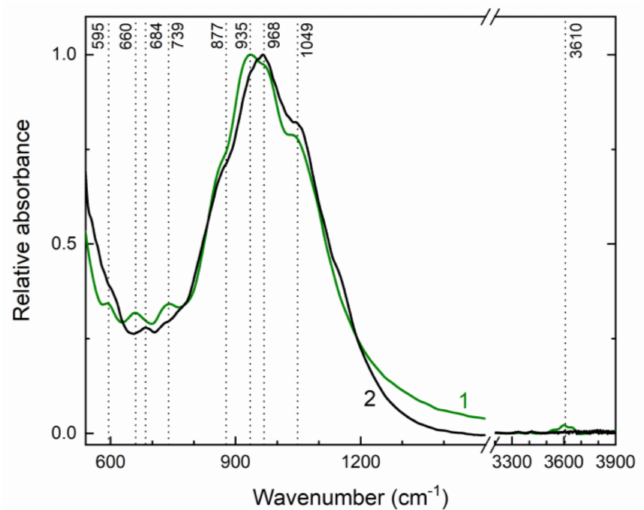
Figure 7. Infrared absorption spectra of initial (green curve 1) and annealed at 750 ◦ C (black curve 2) potassic-hastingsite.